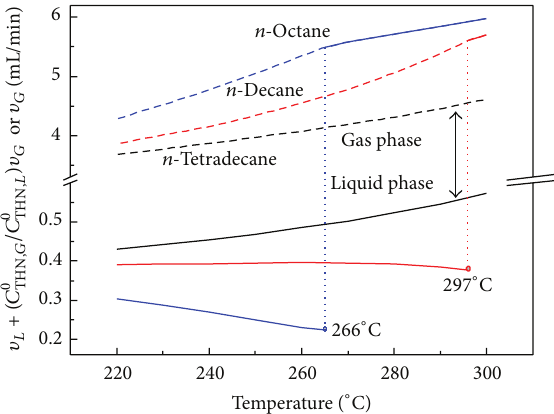
/𝐶 0 )𝜐 𝜐 𝐺 and 𝐺 of different solvents THN ,𝐺 THN ,𝐿